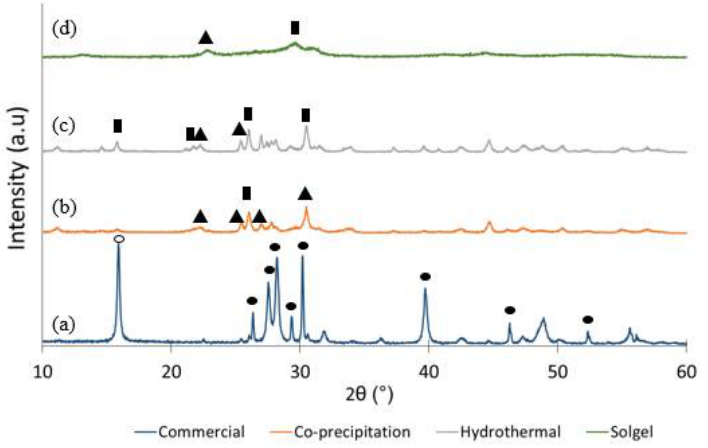
Figure 2. XRD patterns of ( a ) C-La 2 O 3 , ( b ) CP-La 2 O 2 CO 3 , ( c ) HT-La 2 O 2 CO 3 and ( d ) SG-La 2 O 2 CO 3 . (Ο) La(OH) 3 , (●) hexagonal La 2 O 3 , ( ▲ ) hexagonal La 2 O 2 CO 3 and ( ■ ) monoclinic La 2 O 2 CO 3 . Peaks at 22.5, 25.4, 27.0 and 30.4° are characteristic of monoclinic La 2 O 2 CO 3 (JCPDS 48-1113), while peaks at 15.7, 21.4, 25.8 and 29.4° are ascribed to hexagonal La 2 O 2 CO 3 (JCPDS 37-0804). From the XRD data, the major crystalline fraction of CP-La 2 O 2 CO 3 exists in the hexagonal crystal phase, while the major component of HT-La 2 O 2 CO 3 is the mono- clinic crystal phase. C-La 2 O 3 exists in a hexagonal crystal phase (JCPDS 73-2141) [32,33]. The peak at 15.9° is ascribed to La(OH) 3 [29,34]. C-La 2 O 3 is highly sensitive to atmospheric water [35,36], thus the interaction of La 2 O 3 -C with moisture in atmosphere promotes the formation of La(OH) 3 [37]. No strong diffraction peaks are observed for SG-La 2 O 2 CO 3 , in- dicating that it exists in an amorphous state. La 2 O 2 CO 3 -based catalysts were calcined at 400 °C and no peak was detected at 15.9°. The structural properties of the catalyst are therefore highly dependent on the catalyst preparation method. The solid catalysts were also characterised by using Fourier transform infrared (FTIR) spectroscopy as shown in Figure 3. The peak at 3607 cm −1 in the spectrum of C-La 2 O 3 is indicative of the presence of bulk -OH functional groups, supporting the conclusion from XRD that La(OH) 3 forms in the presence of atmospheric moisture. The peaks at 1508 and 1460 cm −1 show that the catalyst surface has reacted with CO 2 and water to form chemi- sorbed carbonate and bicarbonates [38]. C-La 2 O 3 is sensitive to atmospheric CO 2 . The peak at 844 cm −1 is ascribed to carbonate groups [36].